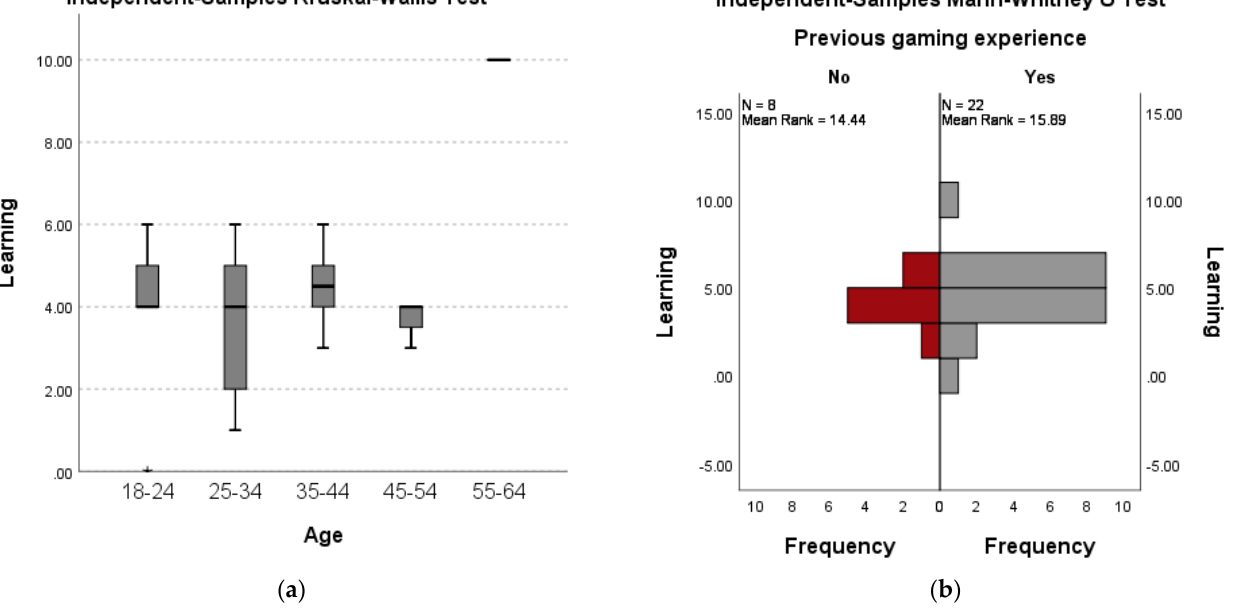
Figure 9. ( a ) Independent samples Kruskal–Wallis Test to determine if the distribution of overall participants learning after playing the game was the same across categories of age; ( b ) Mann–Whit- ney U Test to determine if participants’ learning differed based on participants’ previous gaming